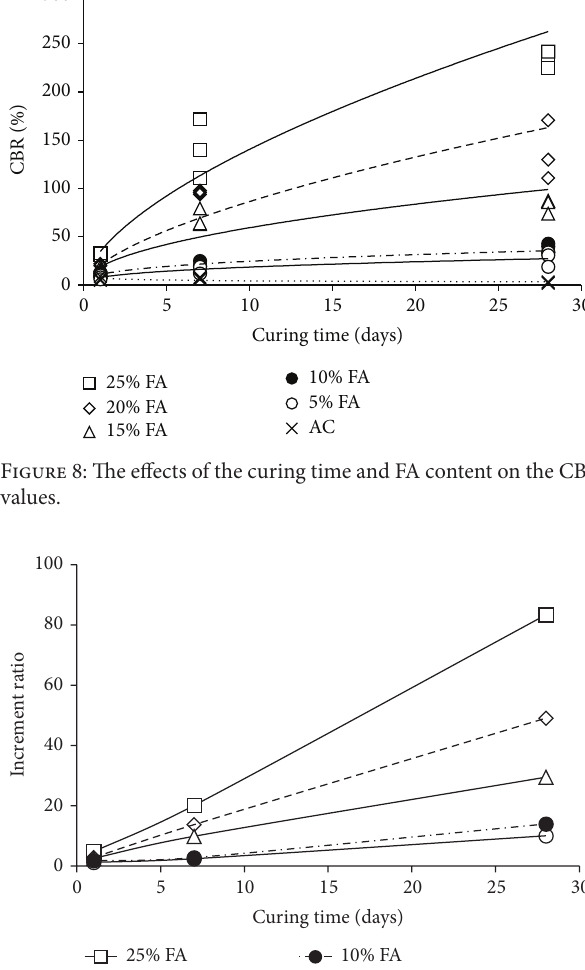
Figure 11: Variation of 𝑐 with FA content and curing